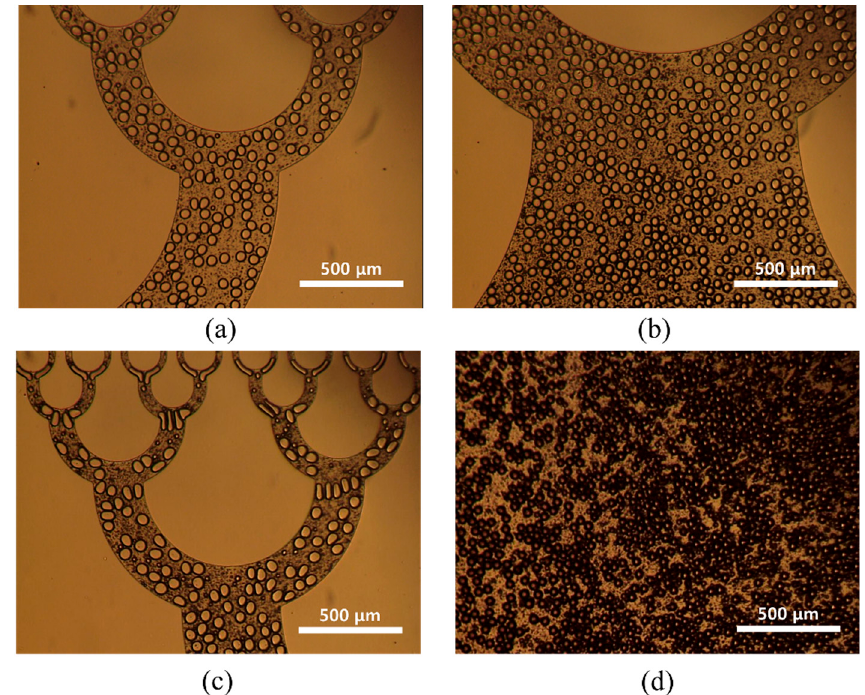
Figure 6. Optical images of prepared water droplets in the collection areas in the 512-channel geometrical passive breakup device: ( a ) first and second collection areas; ( b ) third collection area; ( c ) fourth collection area; ( d ) final collection area.